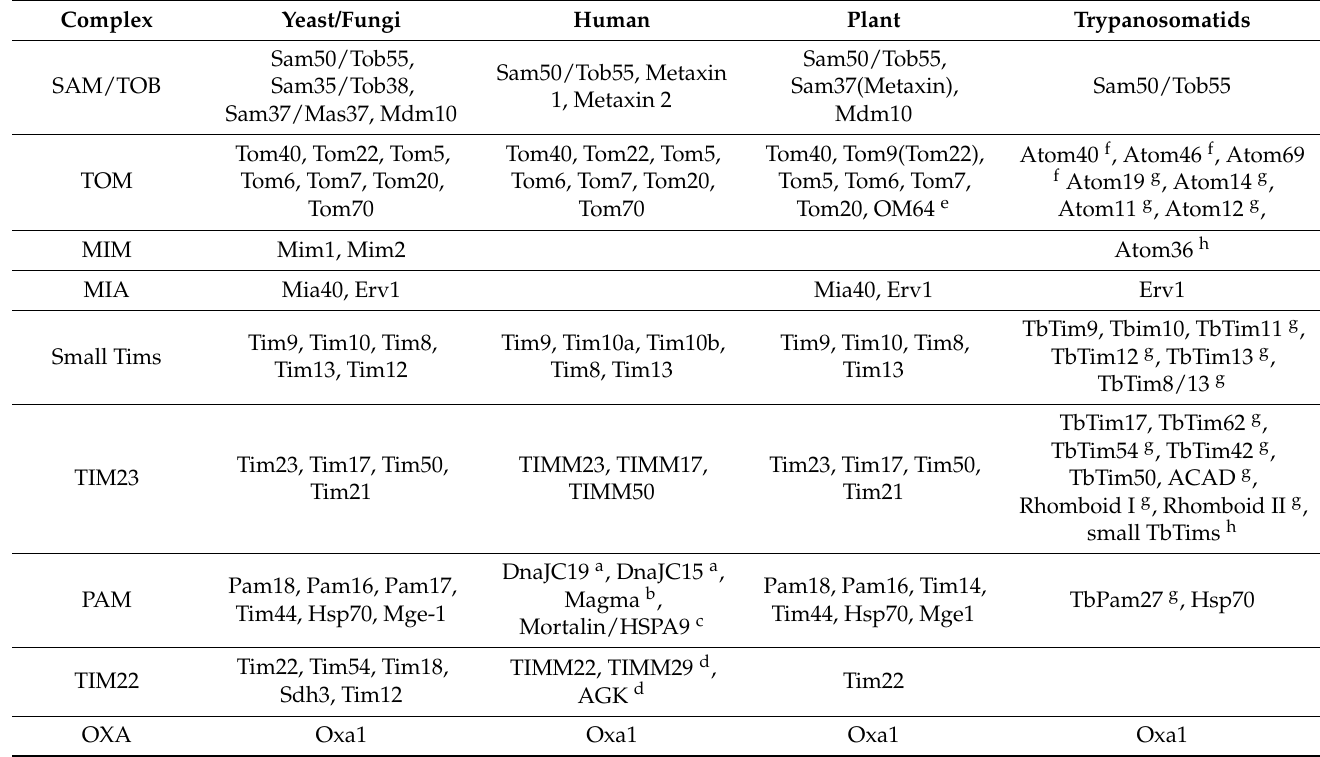
Table 1. Components of the Mitochondrial protein import complexes in different